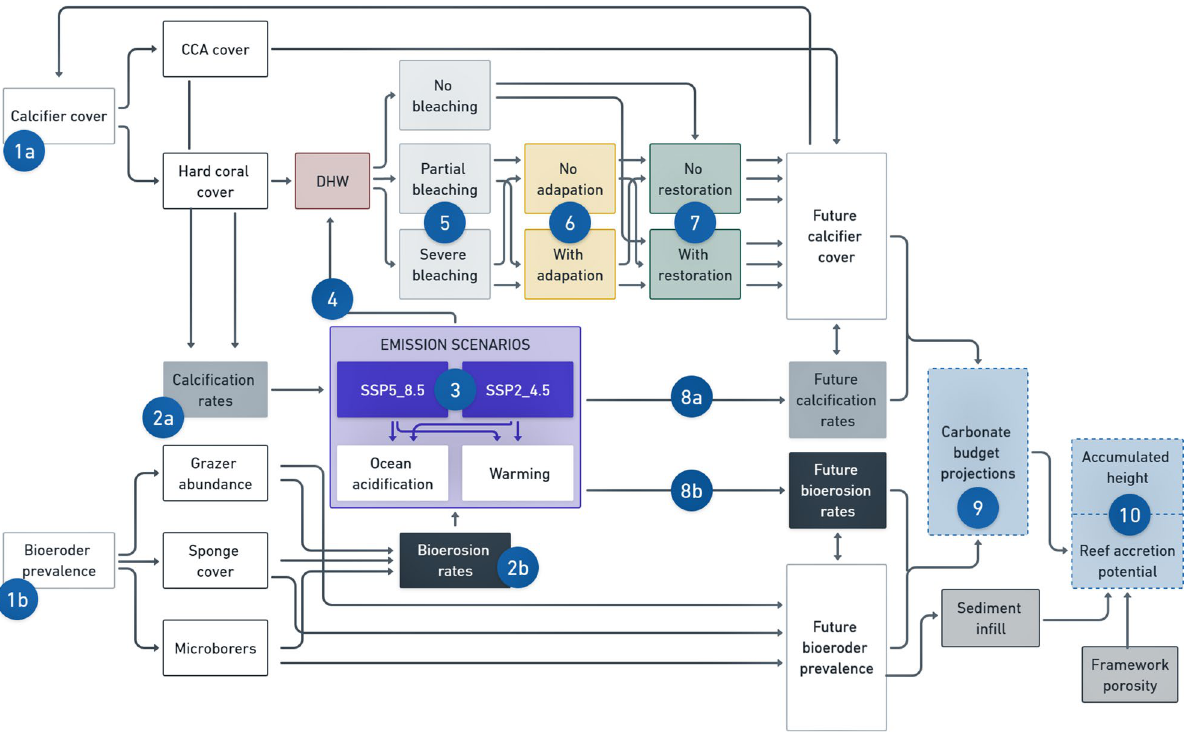
Figure 3. Diagram illustrating the structure of the habitat persistence algorithm for the projection of annual carbonate budget and reef accretion projections. Numbers 1 to 7 relate to the main parameters which are incorporated in the model and are described in detail in the methods section. CCA refers to calcifying coralline algae and DHW refers to degree heating